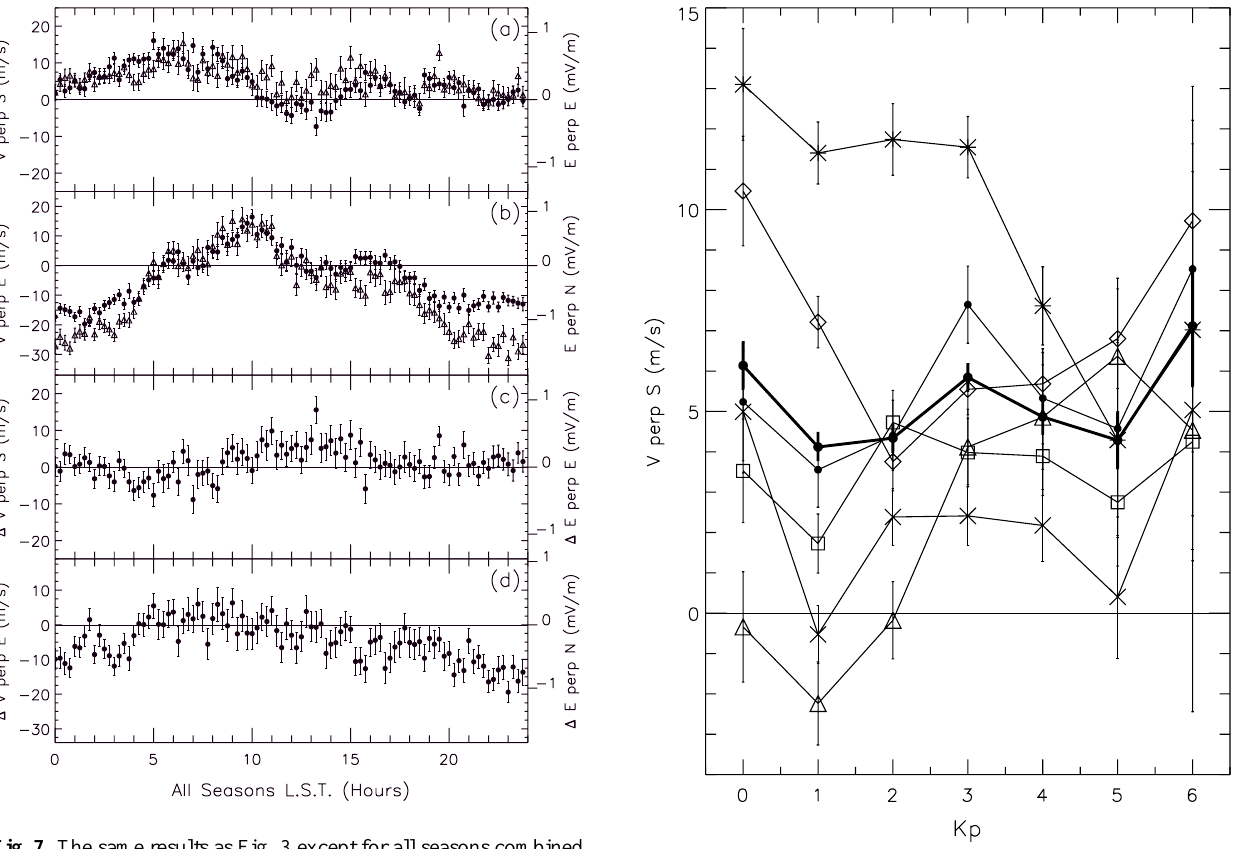
Fig. 8. The dependence of V ⊥ S on the Kp index for different 4- h intervals of LST: 00–04 h (diamonds), 04–08 (asterisks), 08– 12 (small dots), 12–16 (triangles), 16–20 (squares), and 20–24 (crosses). The heavy black line is the weighted average across all intervals of LST. Error bars are standard deviations of the